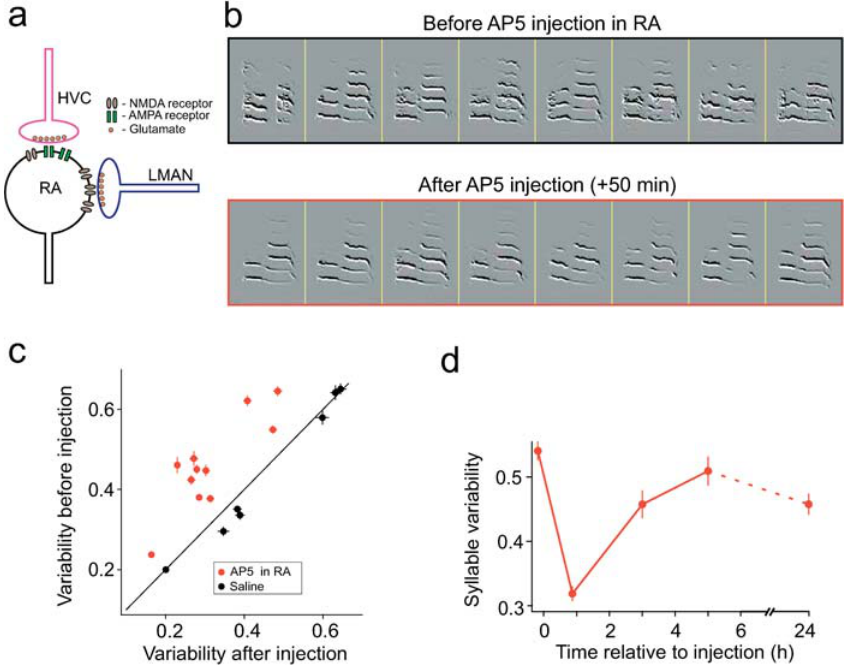
Figure 4. Bilateral Injections of the NMDA Receptor Antagonist AP5 into RA Significantly Reduced Song Variability (A) Excitatory synaptic inputs to RA from LMAN and HVC are mediated by a different mix of glutamate receptor types (see text). Using AP5 we could block LMAN input while only partially inactivating HVC input. (B) Eight sequential renditions of one song syllable in a juvenile zebra finch (63 dph) before and after AP5 injection into RA. Note the rapid fluctuations in pitch, the appearance of noisy acoustic structure, and variations in syllable duration before injection. The average variability scores (V) before and after injections for the eight shown syllable renditions were 0.50 and 0.25, respectively. (C) Following injection of AP5 into RA, fluctuations in acoustic structure were substantially reduced. Variability scores of 11 syllables in four birds before and after injection of AP5 into RA. (D) Time course of acoustic variability following drug injection averaged over all identifiable syllables for the bird in